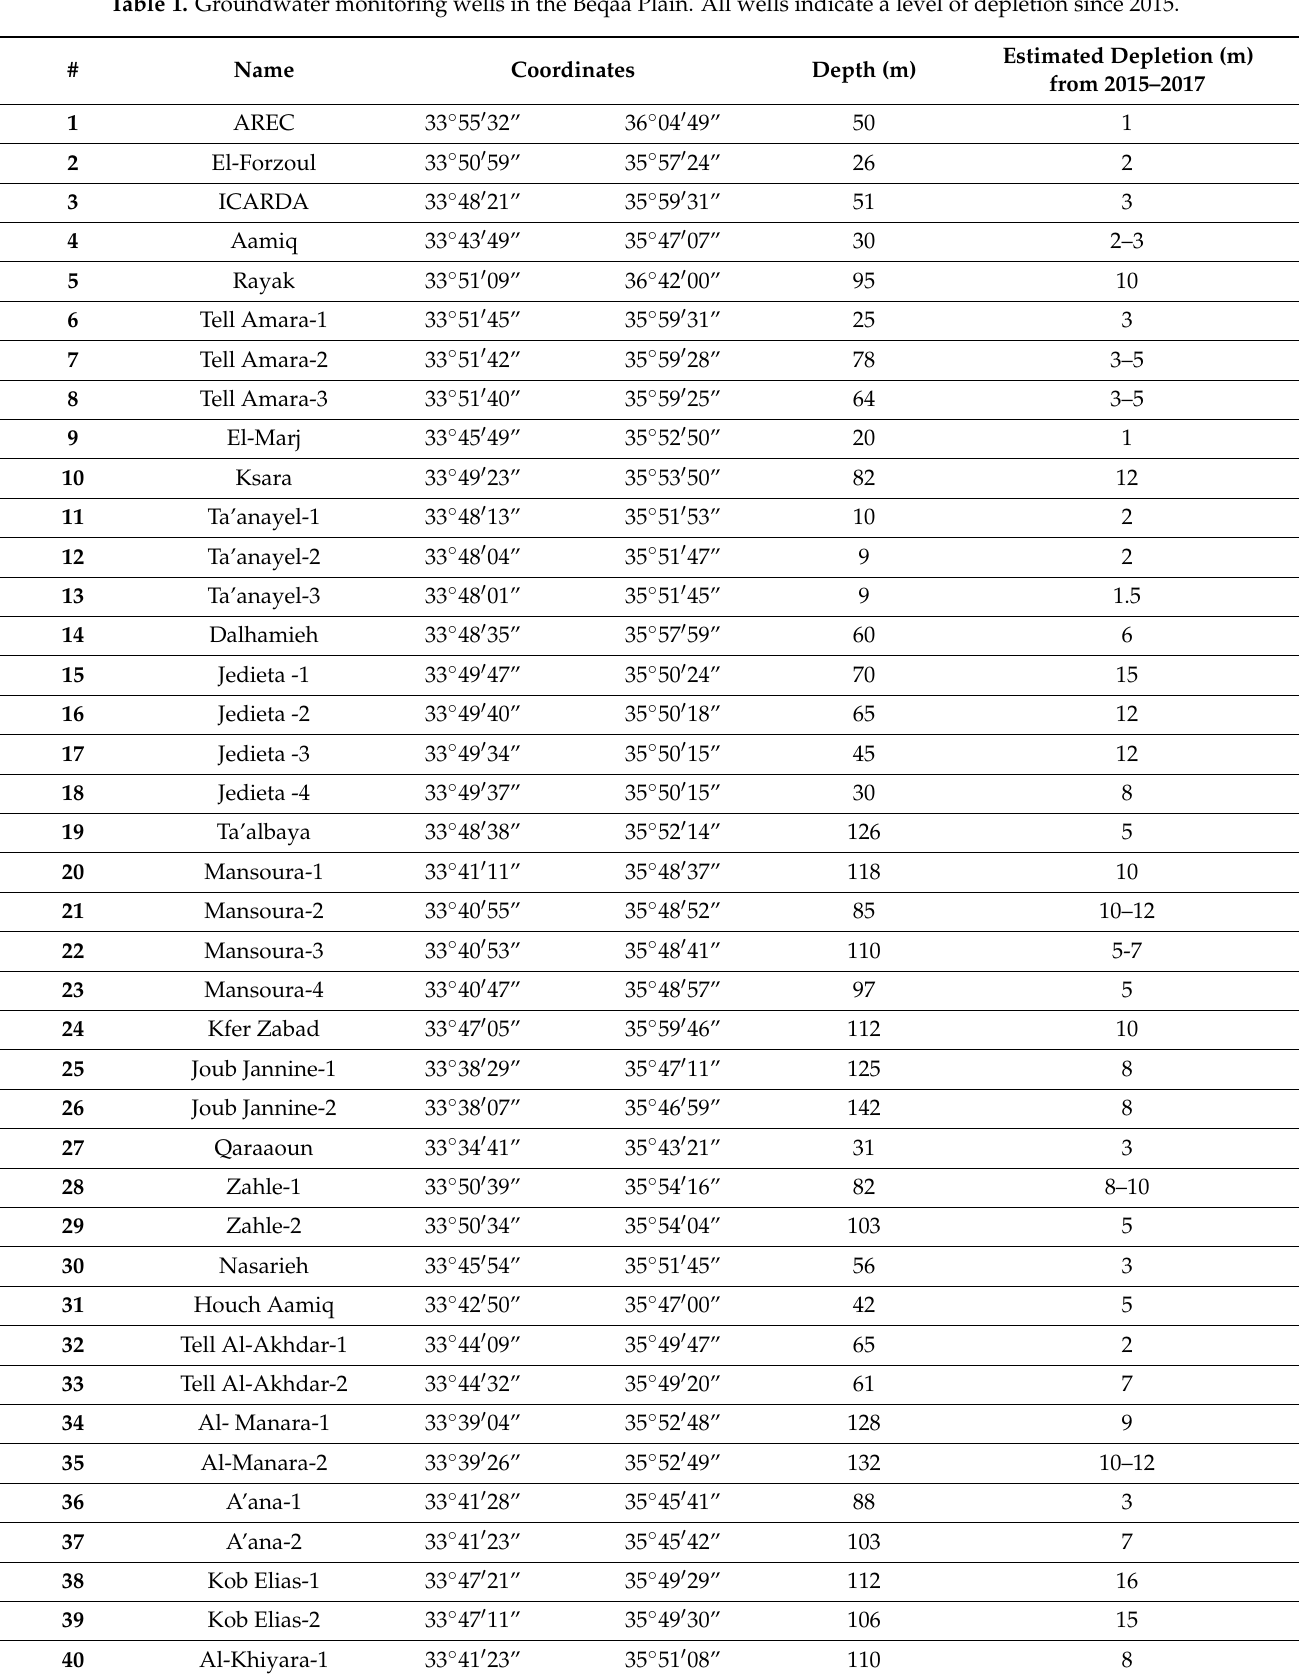
Table 1. Groundwater monitoring wells in the Beqaa Plain. All wells indicate a level of depletion since